Question: What type of chart is this?
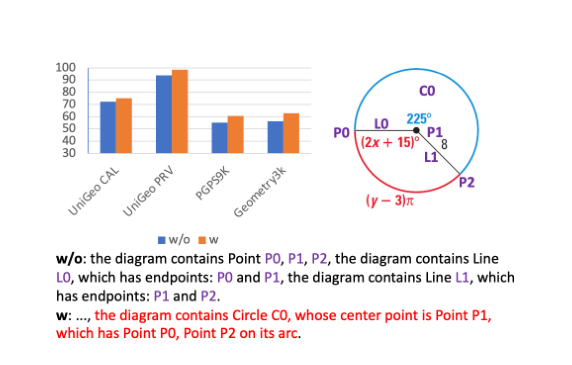
Answer: bar